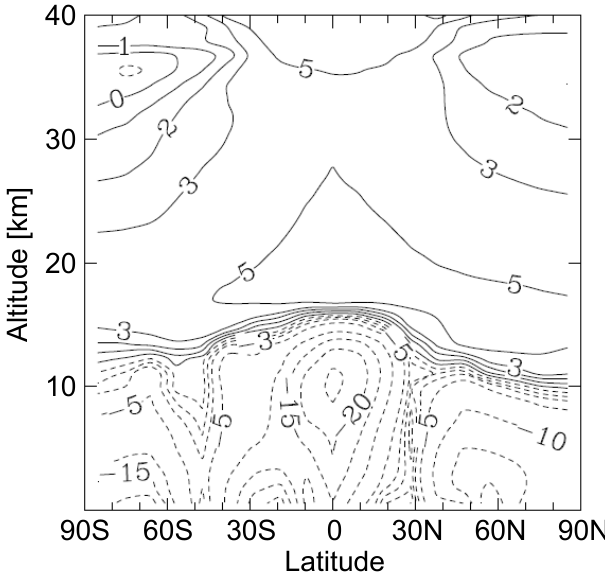
Fig. 10. Percent difference in aerosol surface area densities between runs of the 2-D AER model for “OH minimum” and “outside mini- mum” conditions, as a function of altitude and